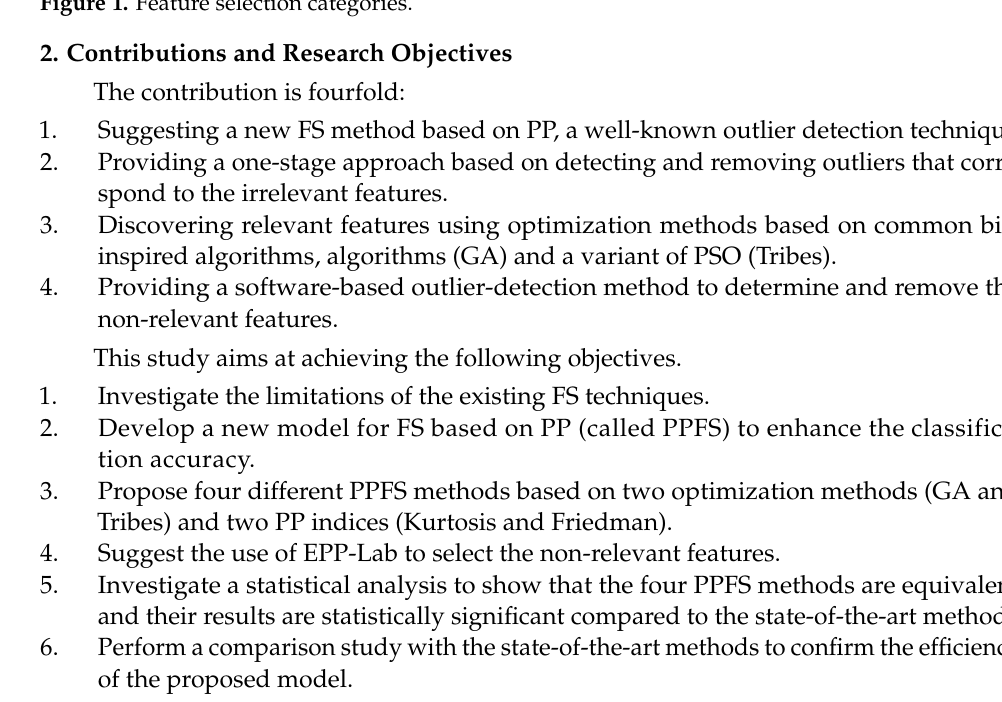
Figure 1. Feature selection